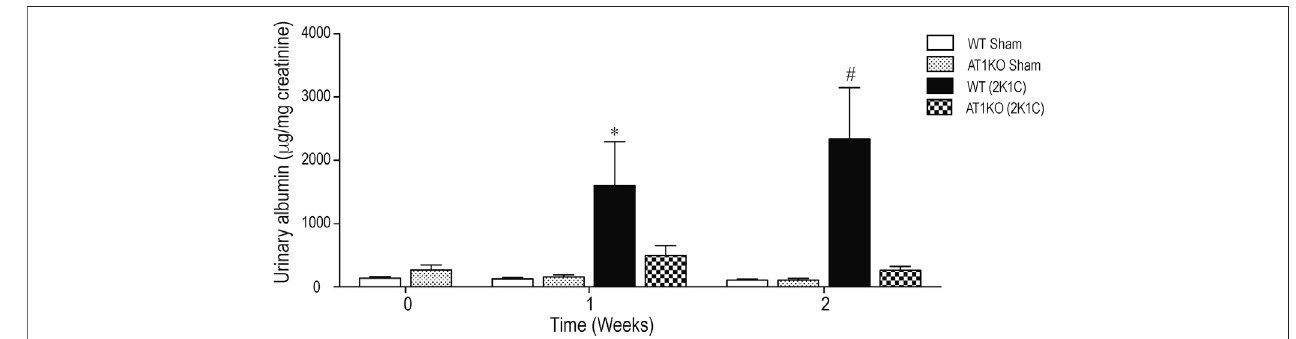
FIGURE 2 | Effect of renovascular hypertension on urinary albumin excretion in WT and AT1KO mice after one and 2 weeks of 2K1C Goldblatt surgery. Urinary Albumin excretion was expressed as μ g/creatinine in WT (sham), AT1KO (sham), WT (2K1C), and AT1KO (2K1C). One-way ANOVA showed a signi fi cant increase of albuminexcretioninWT2K1Cmiceafter1 week(* p < 0.001vs.sham)and2 weeksby(# p < 0.0001)comparedtobaseline,shamgroups,andAT1KO2K1Cmice.Data are represented as mean ± SEM, (n (cid:2) 6 – 10).